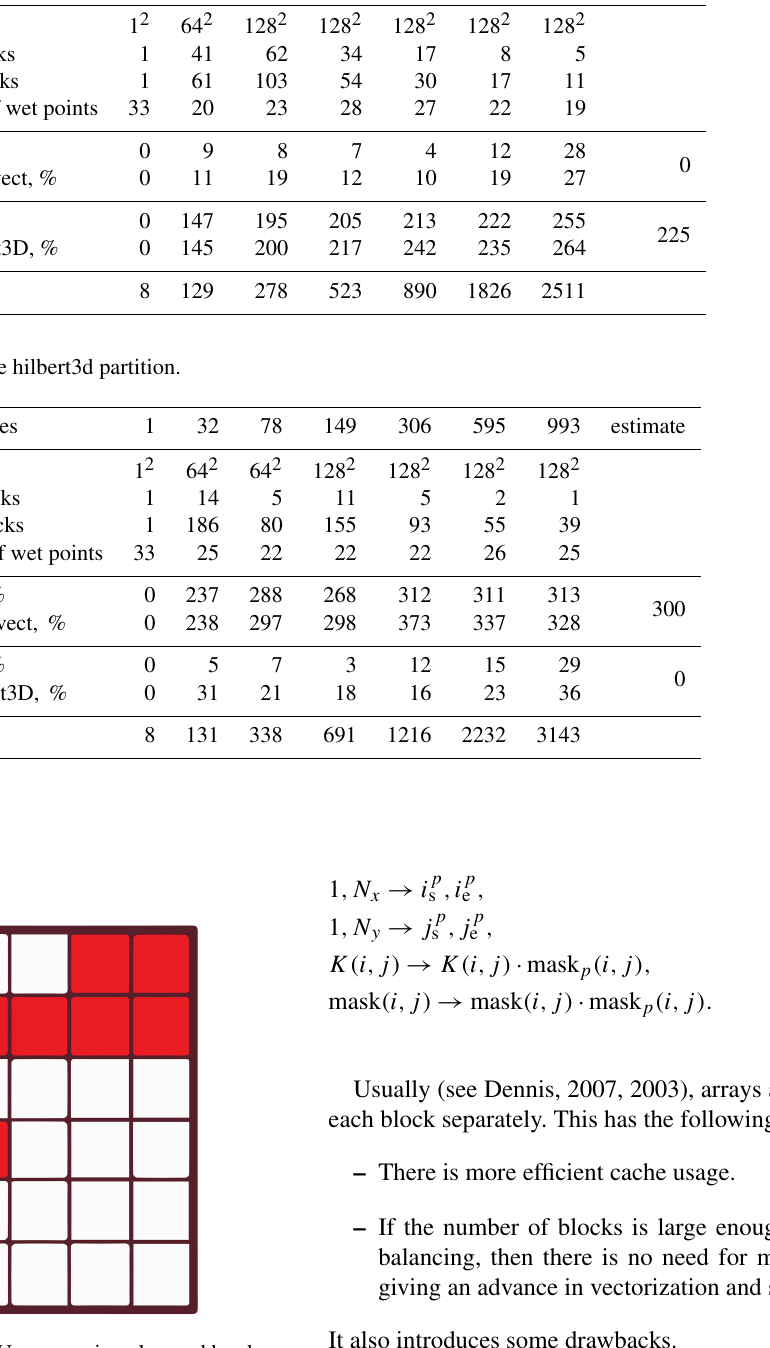
Figure 3. Blocks belonging to a CPU core are in color, and borders of the allocated array are indicated by a thick line; mask p (i,j) = 1 in colored blocks and 0